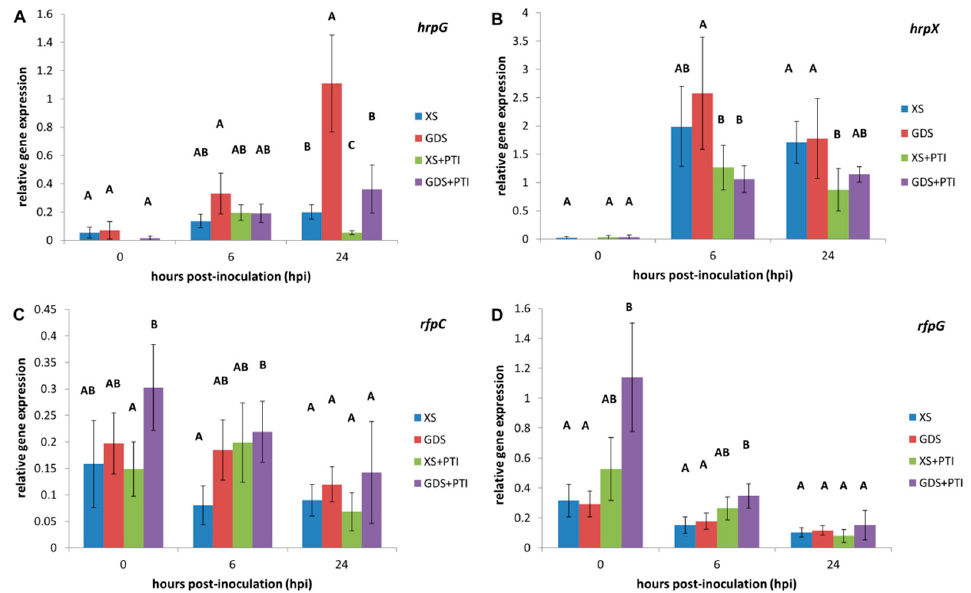
Figure 3. In planta expression of selected T3SS-related regulator genes of X. euvesicatoria as affected by PTI and GDS: ( A ) hrpG; ( B ) hrpX; ( C ) rfpC; ( D ) rfpG . At 0 hpi, the plant leaves were injected with 10 8 cell ml − 1 X. euvesicatoria . PTI was initiated 24 h prior to X. euvesicatoria inoculation by injecting the same leaves with heat-killed P. syringae 61 hrcC . Leaf samples were taken at the indicated time points after X. euvesicatoria infections. To determine the relative gene expression, the measured target gene Ct values were normalized to those of the reference genes ( atpD and rpoB ), and the two relative gene expression values were averaged. Bars represent the mean ± standard deviations of two replicates. The letters above the columns indicate significantly different groups for the values belonging to the given sampling time. XS: susceptible plant, GDS: gds gene-carrying resistant plant, +PTI: PTI activated in plant before X. euvesicatoria inoculation.